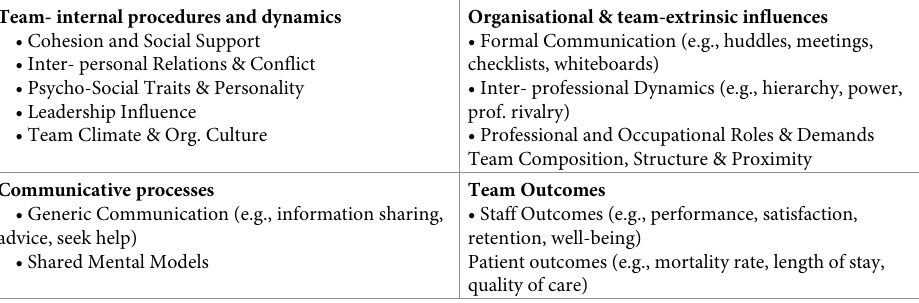
Fig 4. Graphical representation of thematic relationships in reviewed papers. The graph displays the relative importance of the themes by size of the nodes (based on the number of references), the relationships between nodes based on the physical closeness and the size of the connecting lines (derived from the number of references shared by individual themes) and the modularity of the themes (derived from the thematic closeness to each other). The graph further displays the presence of four thematic factors represented by different colours. https://doi.org/10.1371/journal.pone.0272942.g004 Table 3. Overview of synthesised themes by